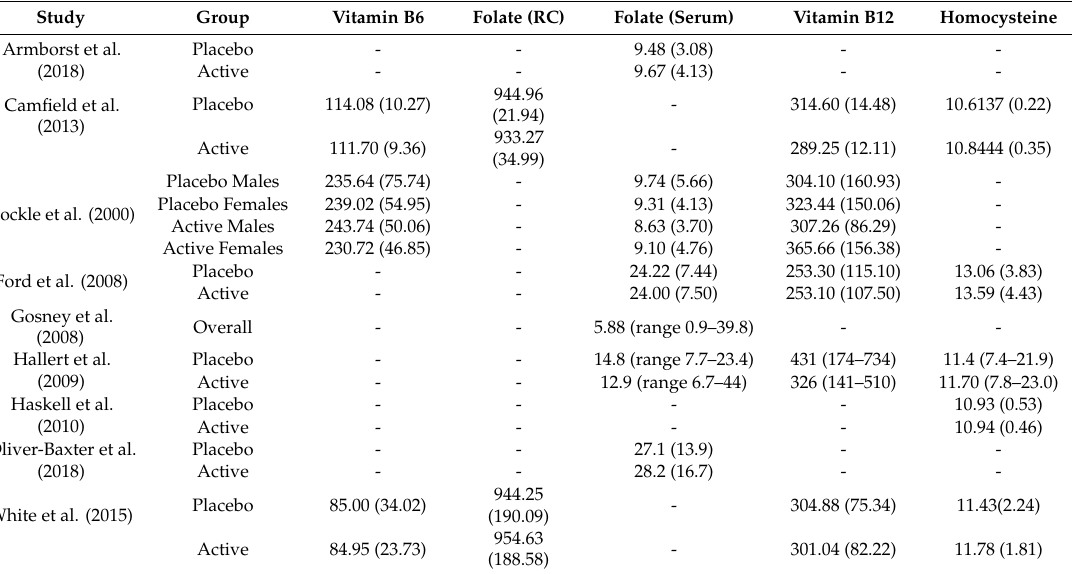
Table 4. Baseline biomarker status.